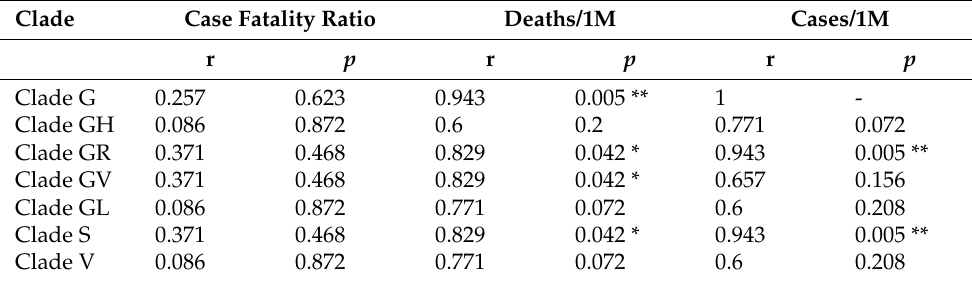
Table 2. Correlation analysis between SARS-CoV-2 clades and Case fatality rates, cases per million and deaths per million among the identified clades in all world continents. Clade Case Fatality Ratio